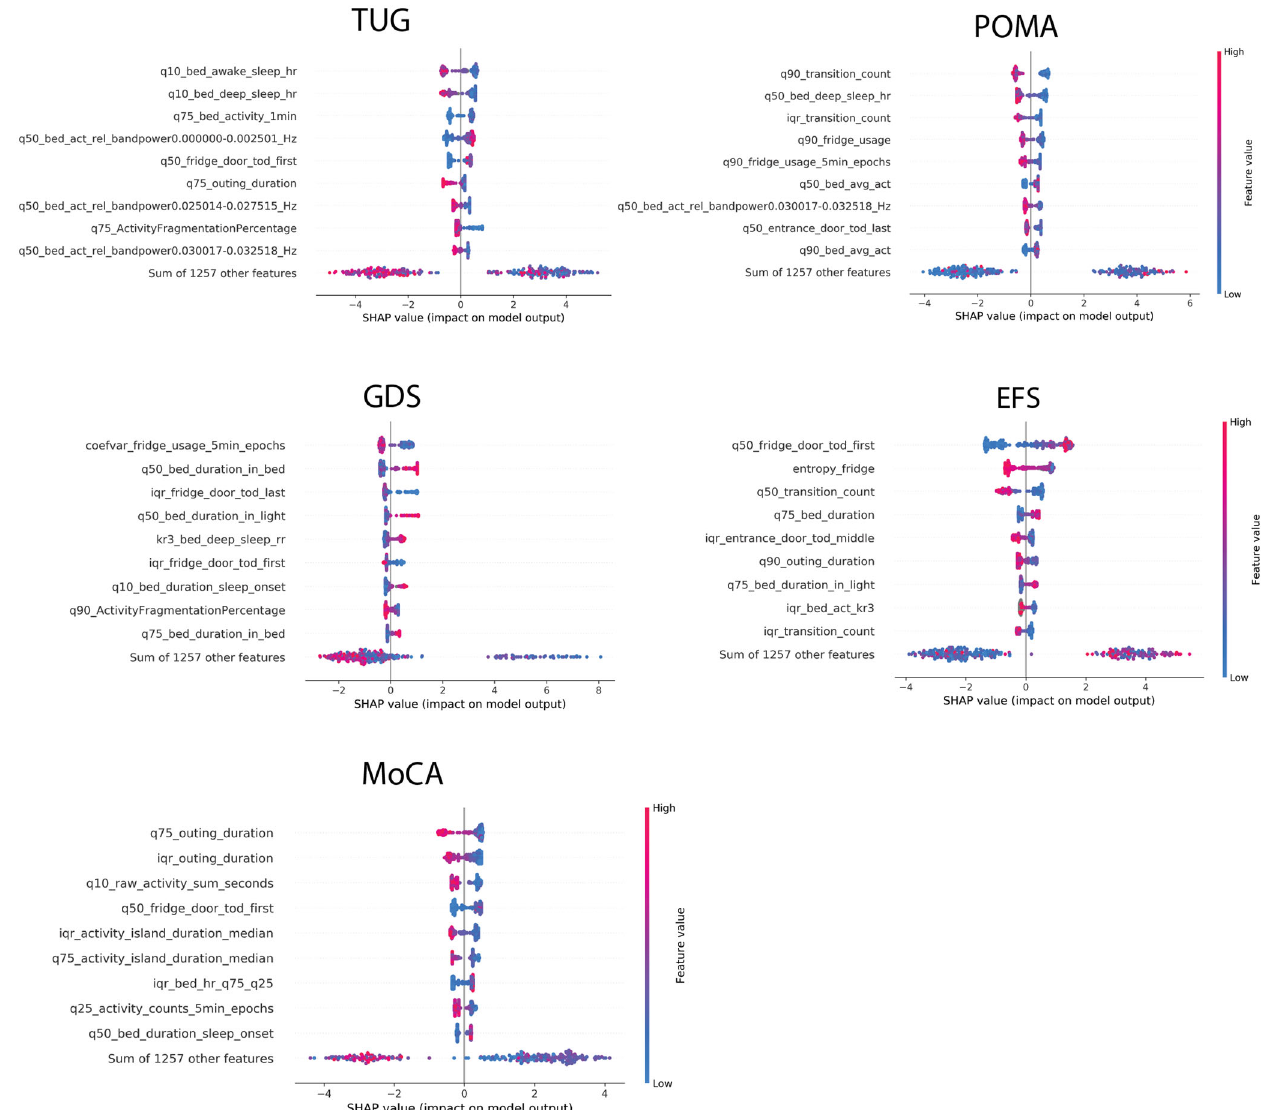
risk, GDS (Geriatric Depression Scale) = late-life depression, EFS (Edmonton Frail Scale) = frailty, MoCA (Montreal Cognitive Assessment) = mild cognitive impairment. Finally, the contributions of the sum of the remaining measures is displayed. Digital measures are ordered according to their importance, from top to bottom. The x-axis represents log odds, where values above zero indicate relevance for a negative outcome. Colouring further shows the direction of this association, where blue indicates lower values of a given measure and red indicates higher respective measure values. Detailed explanations of the individual measure names are given in the supplementary material or on the supplementary website. Note that these plots are based on models trained on the whole respective dataset and are therefore slightly different from the global importances shown in Supplementary Table 3, which are based on 100 simulation